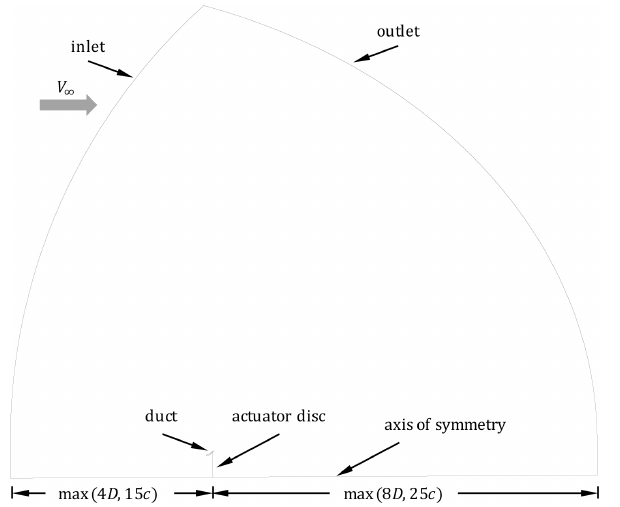
Figure 2. The computational